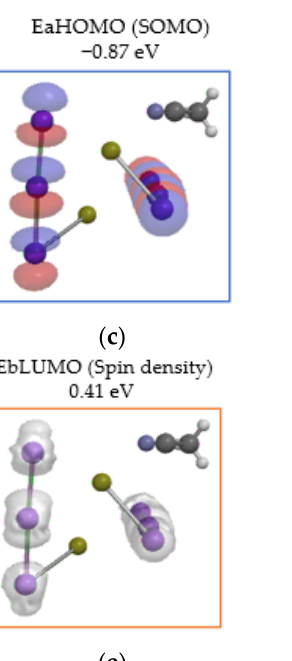
Figure 5. Equilibrium geometry of electron running-state with heat of electron acceptance and energy structures: ( a ) ESPM of [(KI 3 ) 2 and AN] .− ; ( b ) ESPM of [(KI 3 ) 2 and TBP] .− ; ( c ) SOMO configuration of